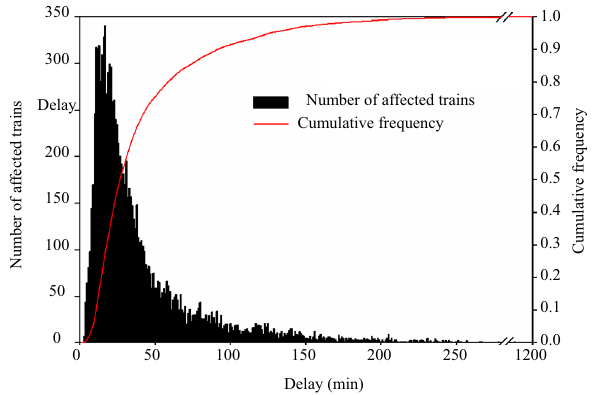
Fig. 2 Number of delayed trains along with delay time